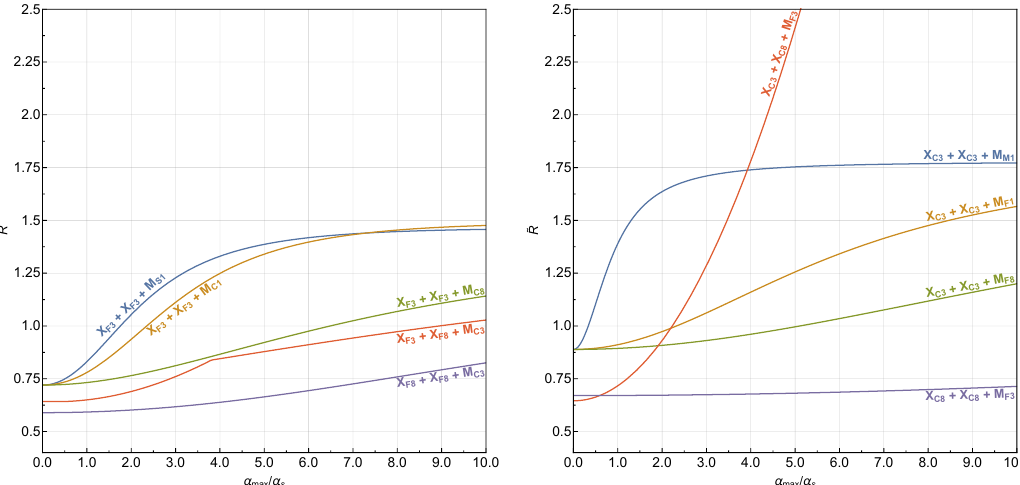
Figure 9 . Ratio of the mixed annihilation rate over the self-annihilation rate ~ R for t -channel models as a function of (cid:11) max for m M = m X . The scalar and fermion X 8 + X 8 + M 3 models (purple lines) do not appear in (cid:12)gure 8 since ~ R is always less than one in these